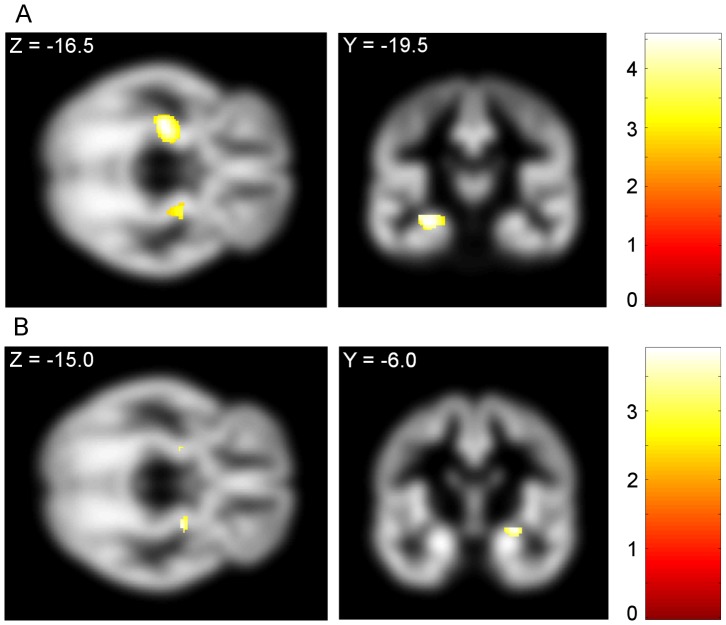
Alcohol Use Disorders Identification Test scores are negatively correlated with hipppcampus and amygdala grey matter volume.A) Regions of hippocampus and B) amygdala negatively correlated with Alcohol Use Disorders Identification Test scores across groups. Hippocampus: Left side: −30.0, −19.5, −16.5; Z = 3.93, FWE-corrected P = 0.009; cluster size = 289. Amygdala: Left side: −22.5, −9.0, −12.0; Z = 3.08, FWE-corrected = 0.037; cluster size = 4. Right side: 27.0, −7.5, −13.5; Z = 3.46, FWE-corrected P = 0.012; cluster size = 43. All images are shown at whole brain uncorrected P<0.005, cluster size >0, overlaid on the mean group grey matter image, and masked by the atlas delineations of these structures in neurological convention. Voxel-wise t-values are color coded according to legend.